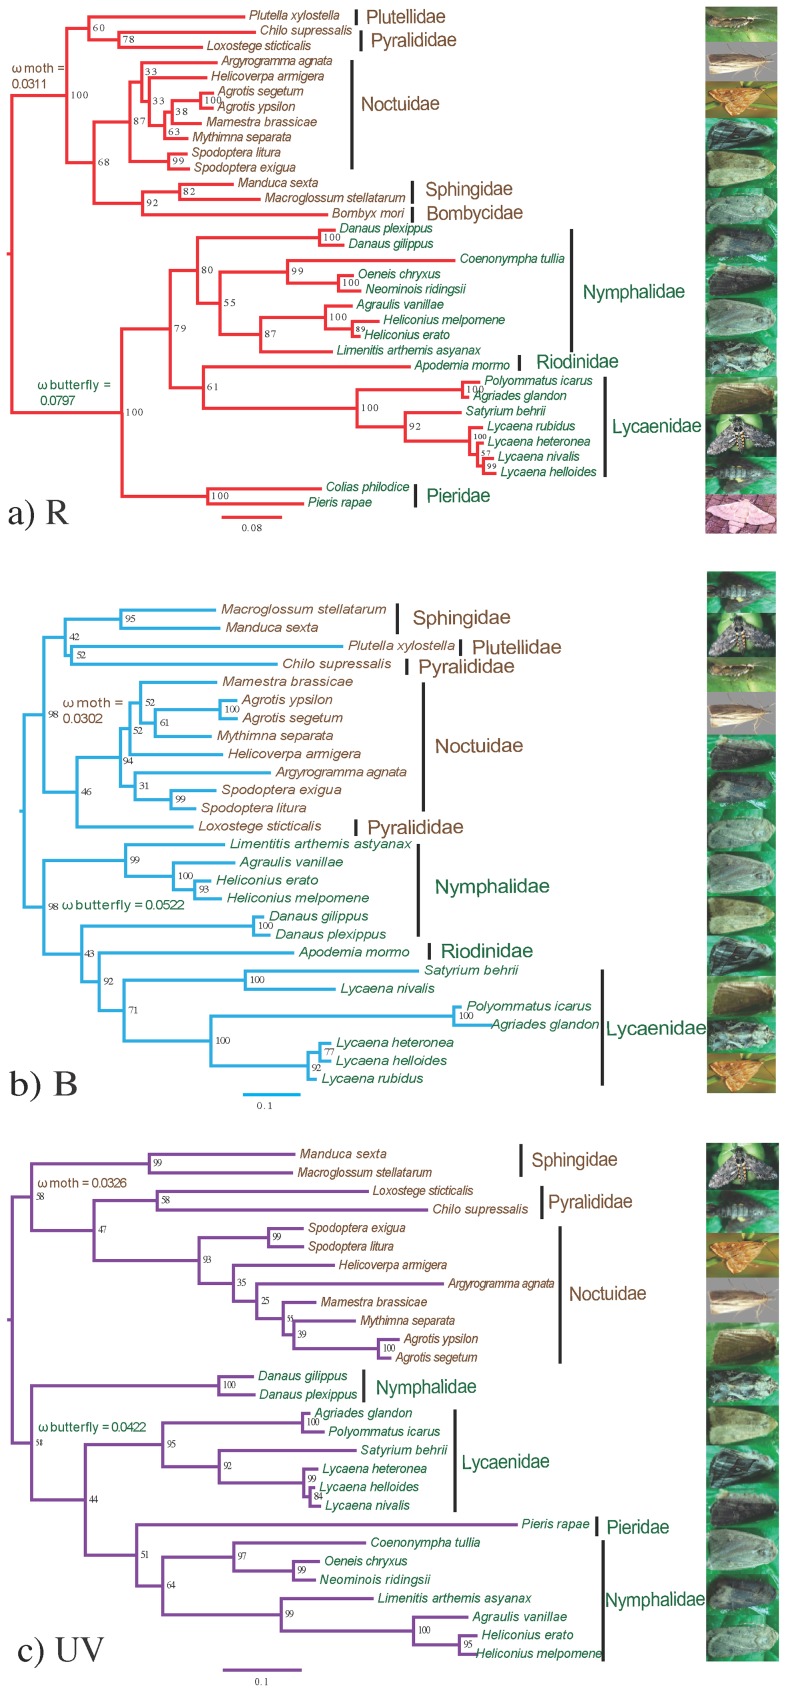
Phylogeny of opsin genes in Lepidoptera based on maximum likelihood.Values on the nodes are the nonparametric bootstrap proportions (MLBPs). Moths denoted in blue and butterflies in red. Branch-specific ω values are shown on nodes of the common ancestors. a) R opsin; b) B opsin; c) UV opsin. Figures at right show the moths.